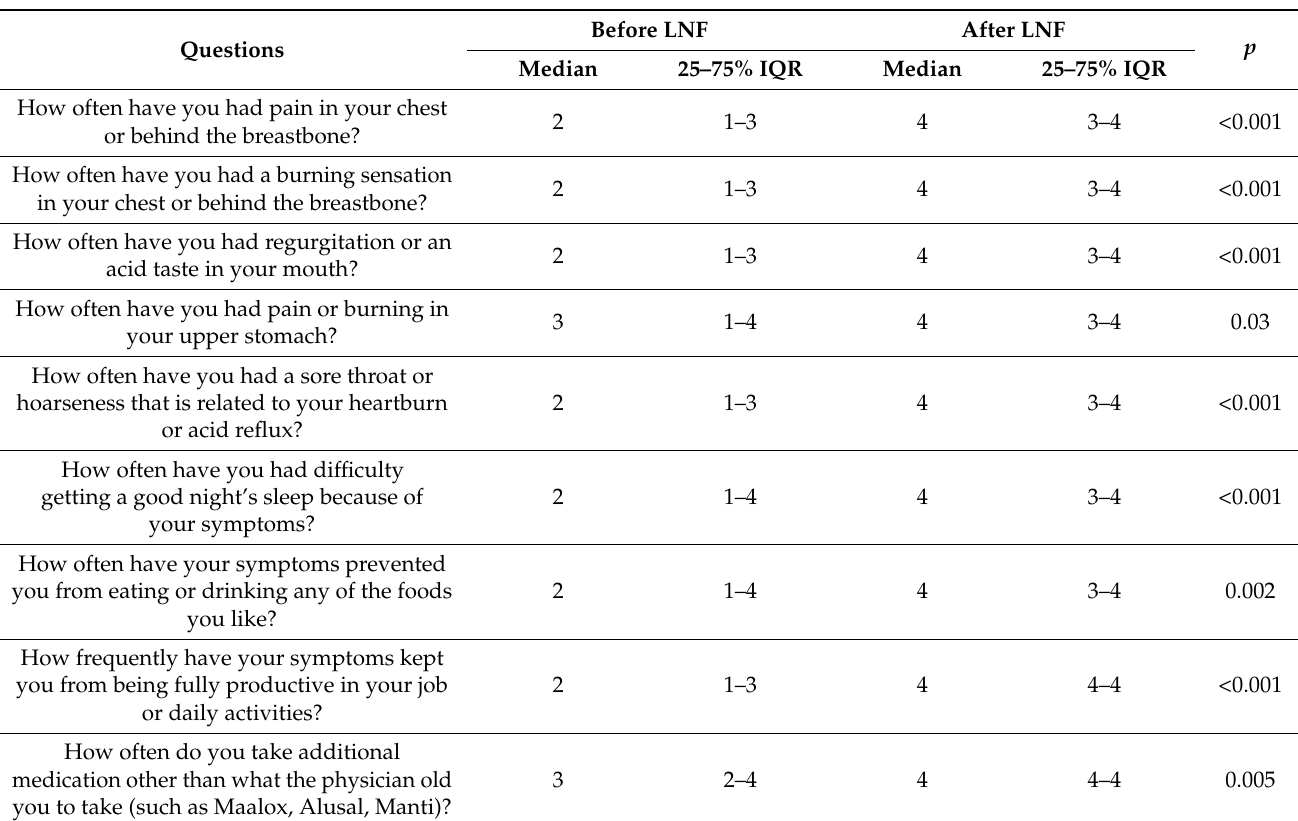
Table 2. Median and interquartile range of GERD-IS before and after the surgery. (1—daily; 2—often; 3—sometimes;